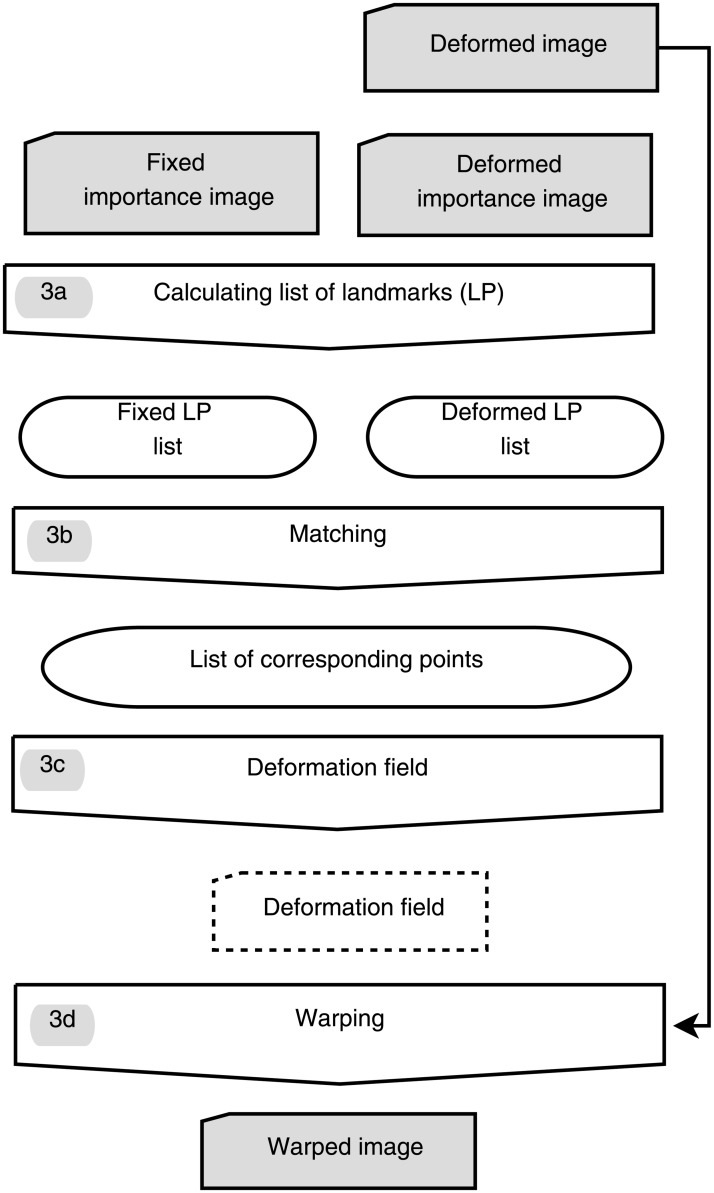
Detailed work flow for step 3.(3a) calculation of leading points (LPs) for each image. (3b) finding corresponding LP and create a list of corresponding points. (3c) calculation of a deformation field i.e. displacement vectors for each voxel. (3d) warping the deformed image.